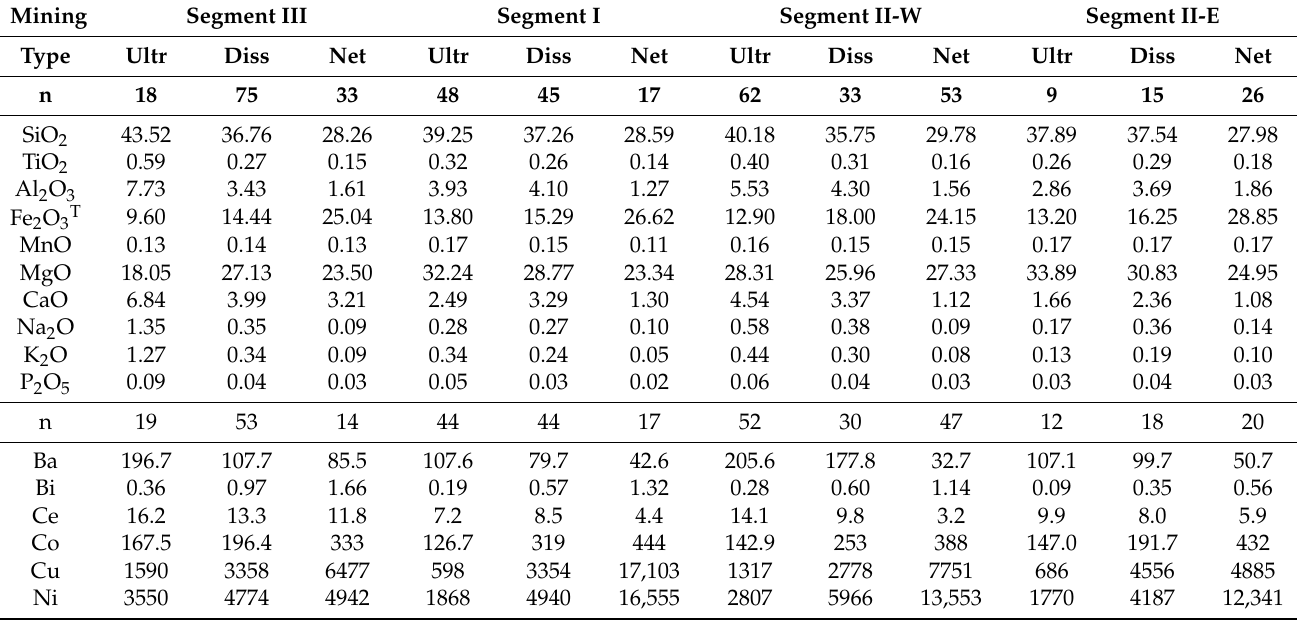
Figure 7. Density plot of raw ( a , c ) and centered-log ratios transformed ( b , d ) dataset. The data source is the same as Figure 6. Table 1. Average values of major and trace elements for different ore types after data pre-processing from Jinchuan deposit.